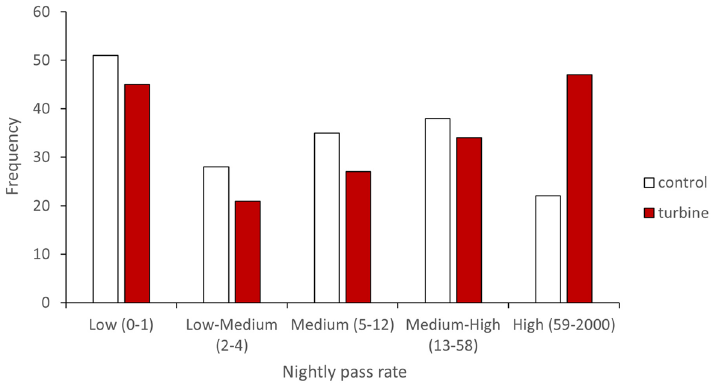
Figure 1. Frequency of nights of P. pipistrellus activity which can be classed at either low (1st–20th percentile), low–medium (21st–40th percentile), medium (41st–60th percentile), medium–high (61st–80th percentile), or high (81st–100th percentile) activity levels split between turbine and control locations.